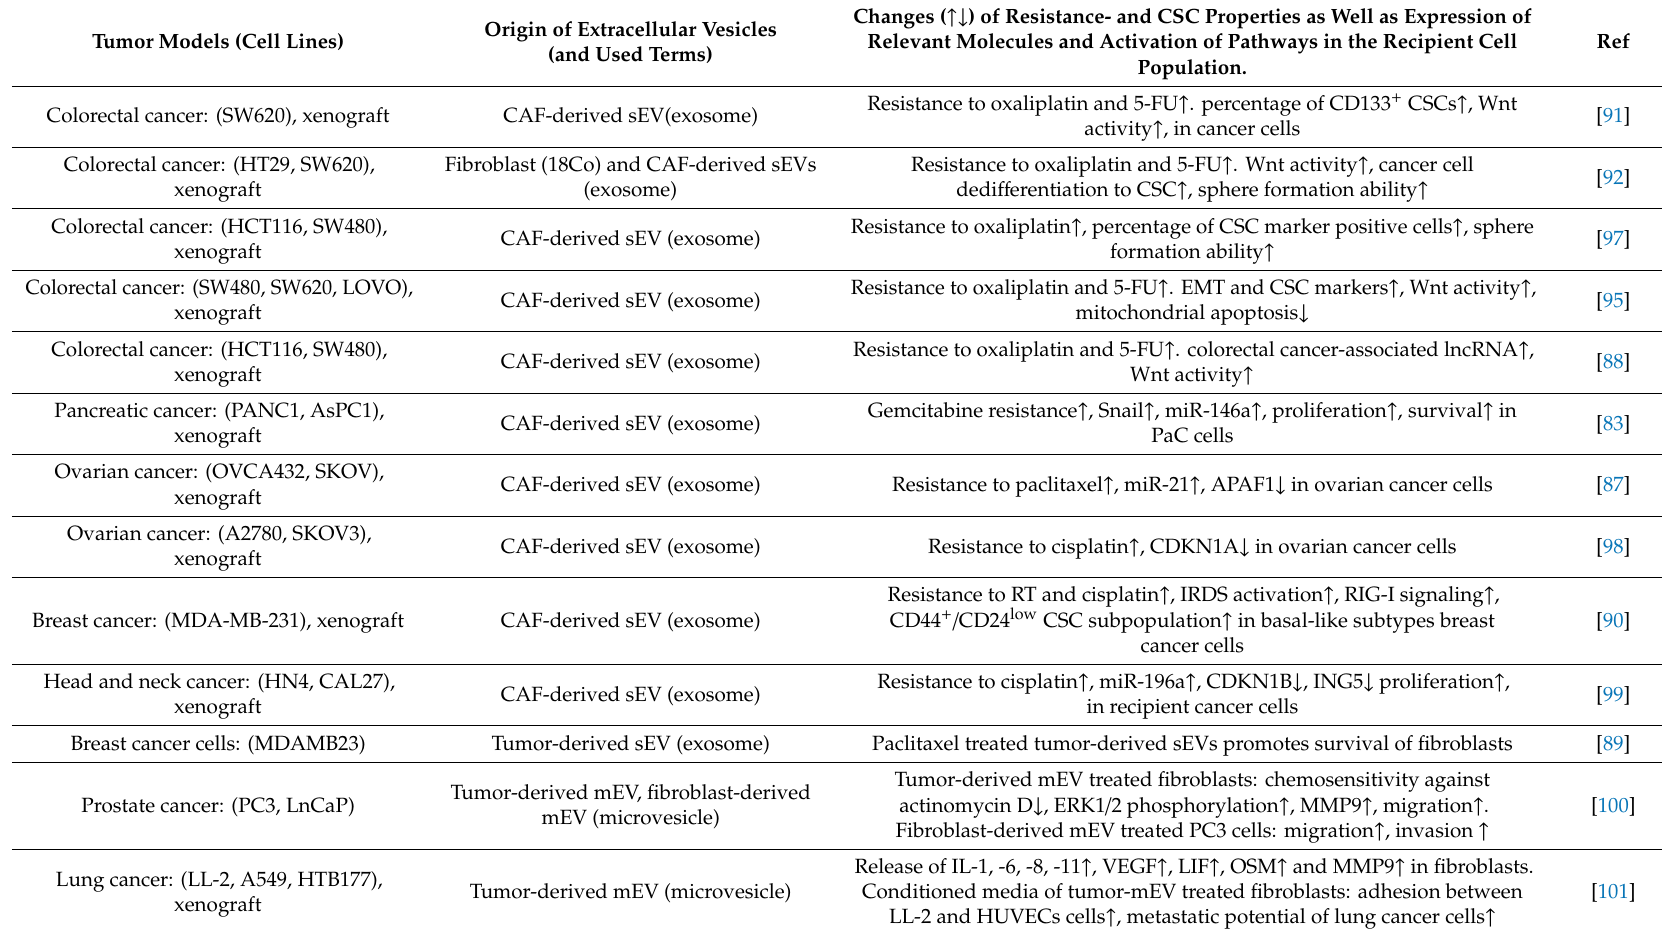
Table 1. Tumor cell-CAF EV-based crosstalk and its e ff ect on chemotherapy and radiation therapy (RT). Origin of Extracellular Vesicles Tumor Models (Cell Lines) (and Used Terms)